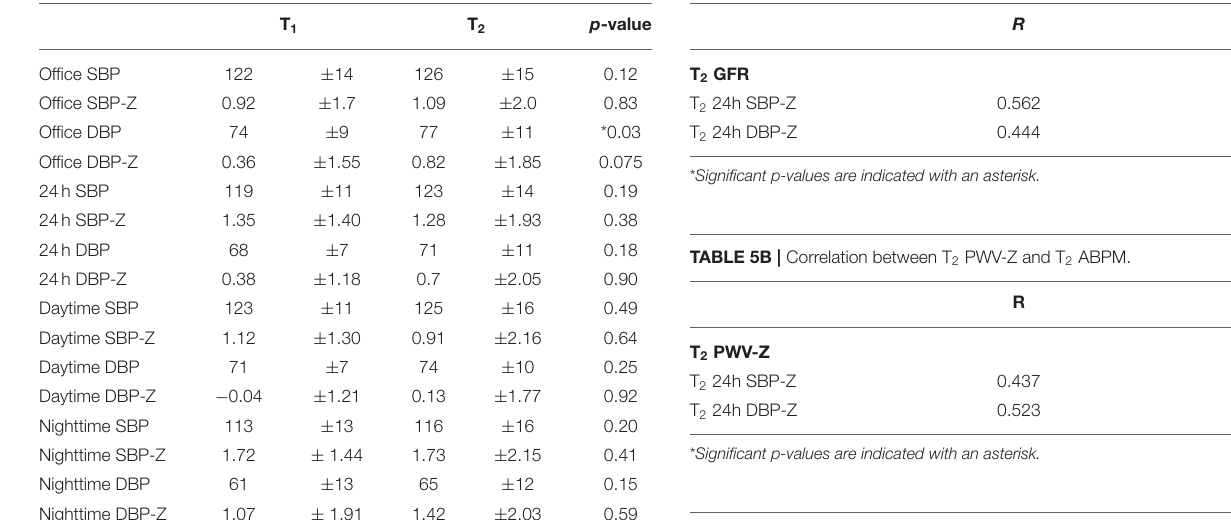
TABLE 5C | Comparison of renal function outcomes between controlled and uncontrolled